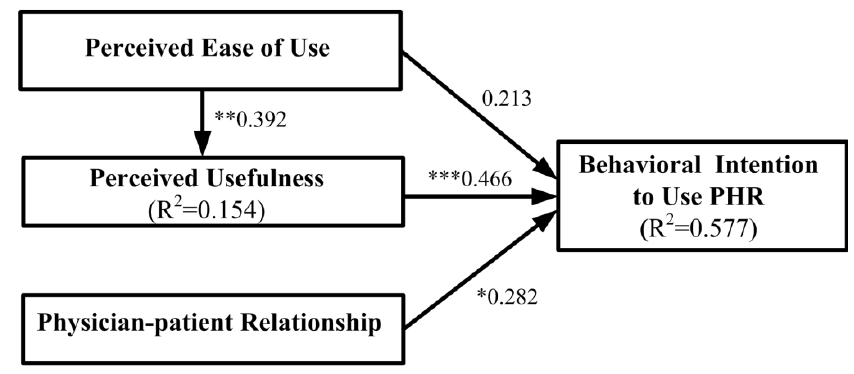
Figure 3. Results of the path modeling